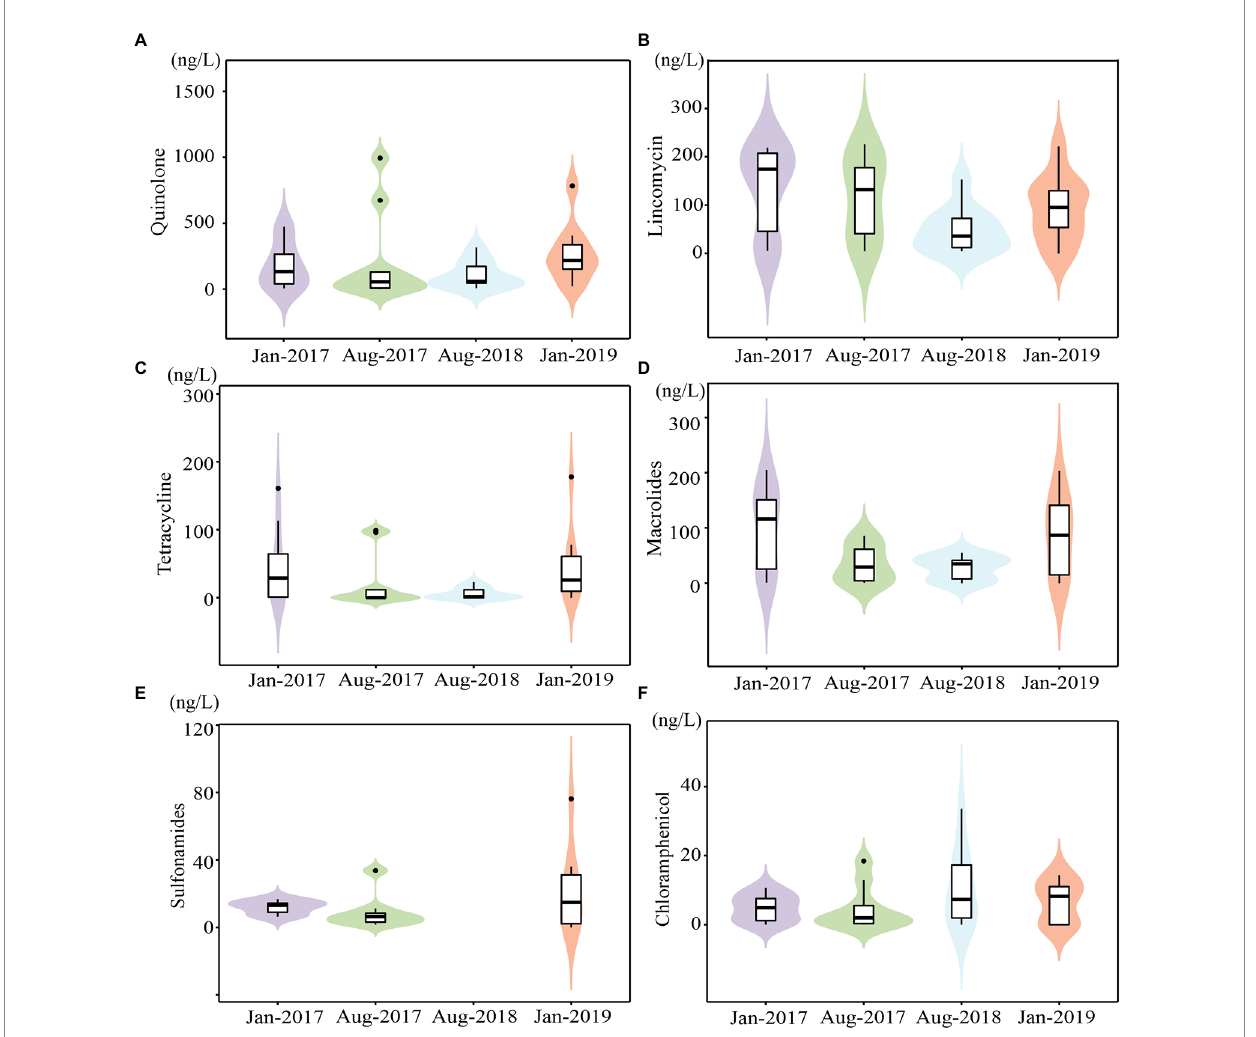
FIGURE 2 The concentrations of main antibiotics in karst river at four sampling times (Jan-2017, Aug-2017, Aug-2018 and Jan-2019). (A–F) The concentrations of quinolones, lincomycin, macrolides, tetracyclines, sulfonamides and